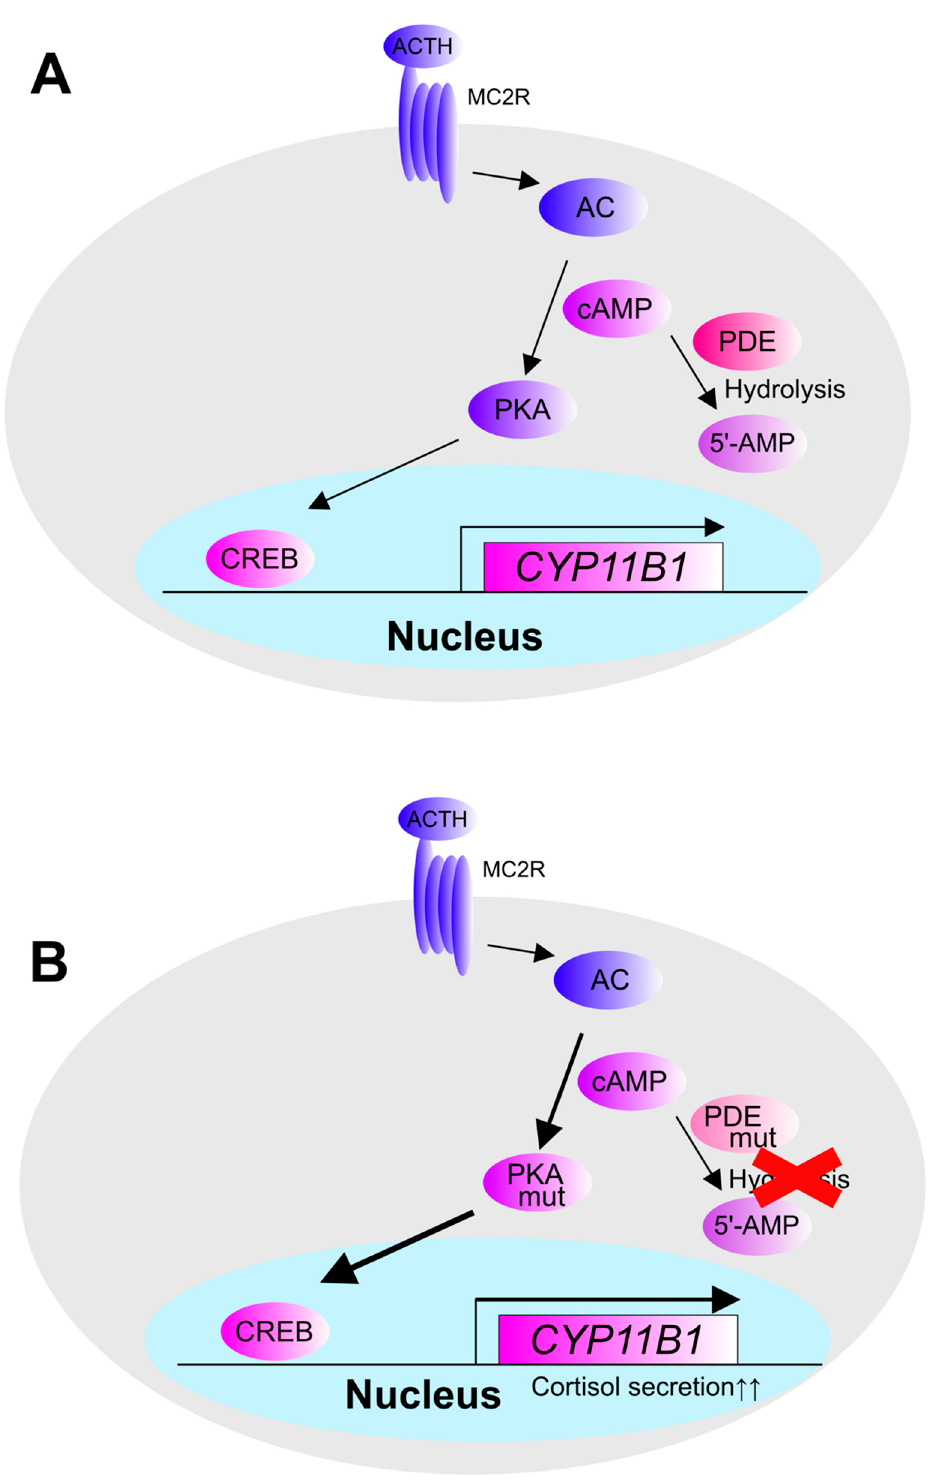
Figure 6. Genetic mutation in CPA. Cortisol is secreted by inducing the gene expression of CYP11B1, and ACTH activates cAMP-PKA signaling by binding to MC2R of ZF cells, inducing the gene expression of CYP11B1 . ( A ) Normal adrenal cAMP-PKA pathway. ( B ) Gene mutation in adrenal cAMP-PKA pathway. In CPA, mutations in PRKAR1B , PRKACA , and PRKACB , which are subunit genes of PKA, and mutations in PDE8B and PDE11A, which are enzymes that degrade cAMP, have been reported.